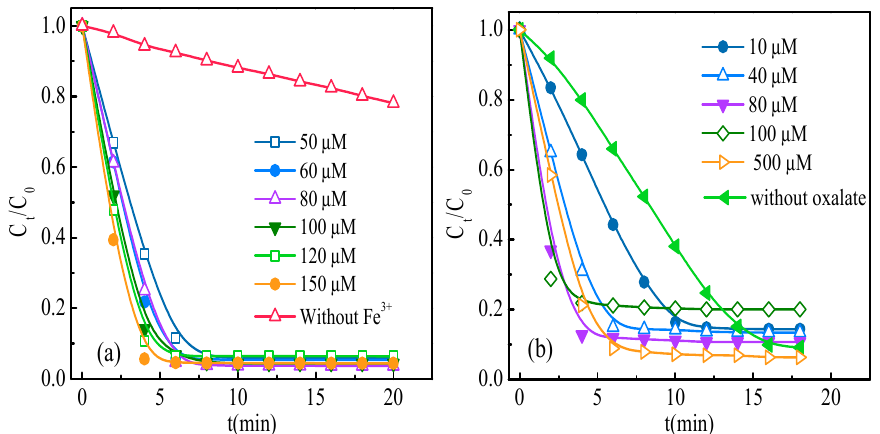
Figure 5. The effects of the Fe 3+ concentration ( a ) and oxalate concentration ( b ) on the decolorization of Orange ([Fe 3+ ] 0 = 100 µM [Orange II] 0 = 50 µM, [PMS] 0 = 150 µM, under UVA irradiation, λ irr. = 365 nm, pH 3).